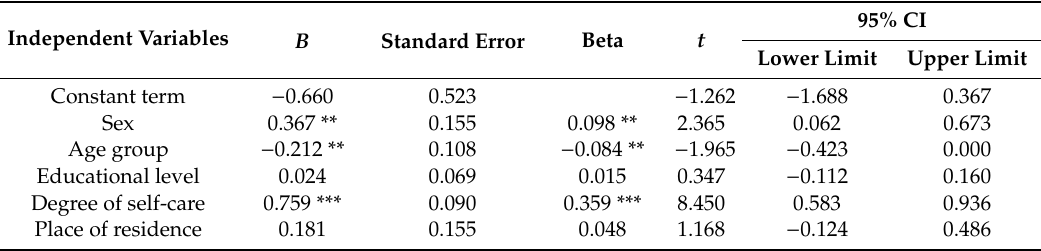
Table 7. Linear regression results of the understanding of COVID-19 among the elderly individuals. Independent